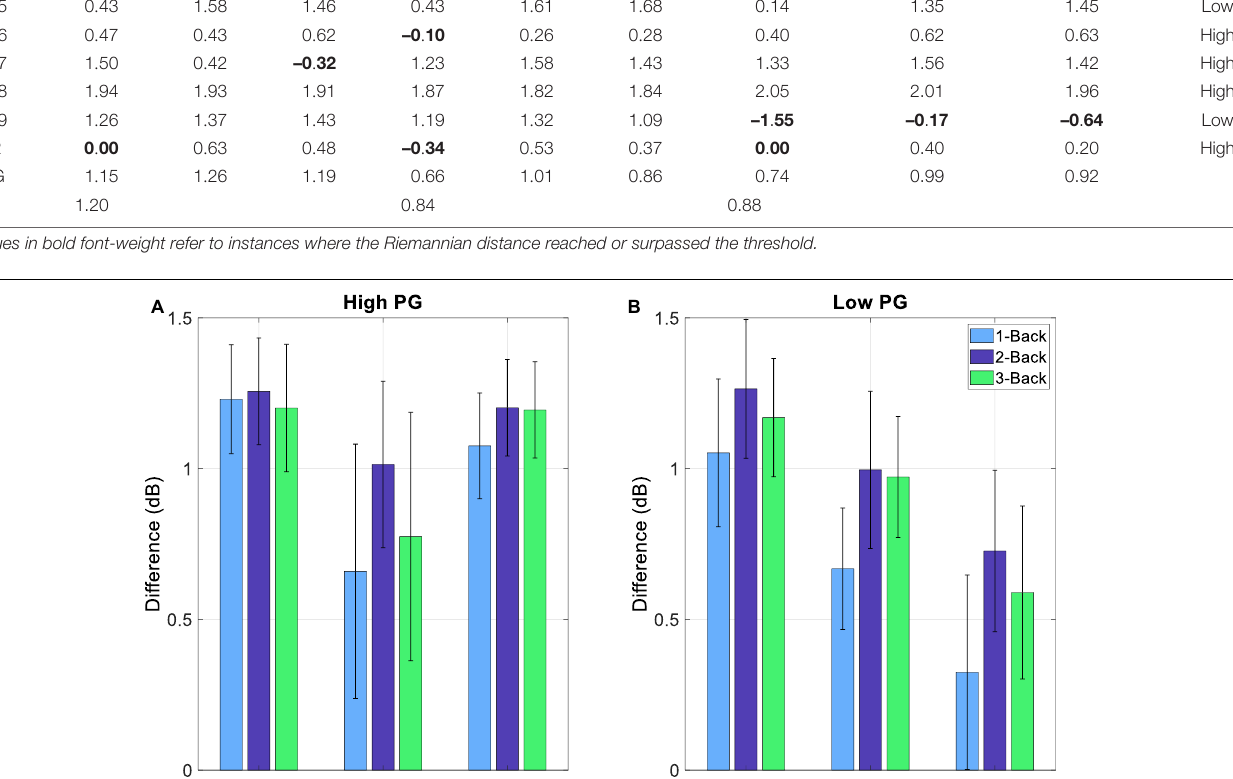
that MWL and MF are correlated with task performance. Our results are in accordance with previous studies Käthner et al. (2014) and Roy et al. (2013) that show that task performance decreases with increasing MWL and